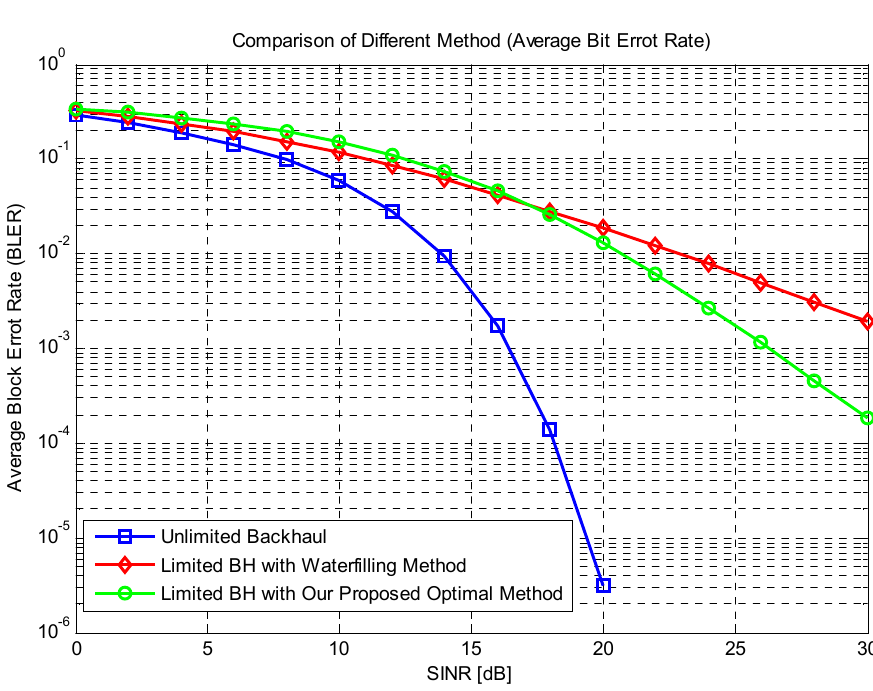
Figure 8. Average BLER of different SINR.